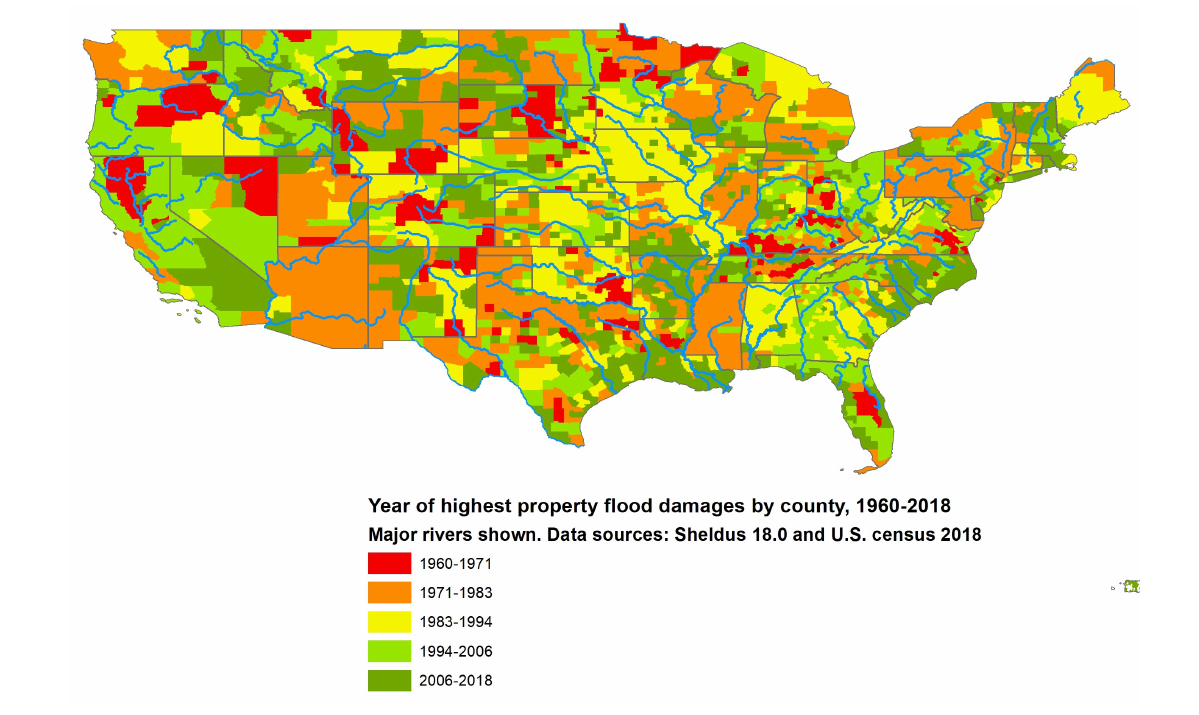
Fig. 6 . Temporal vulnerability map, based on temporal distance from proxy baseline flood